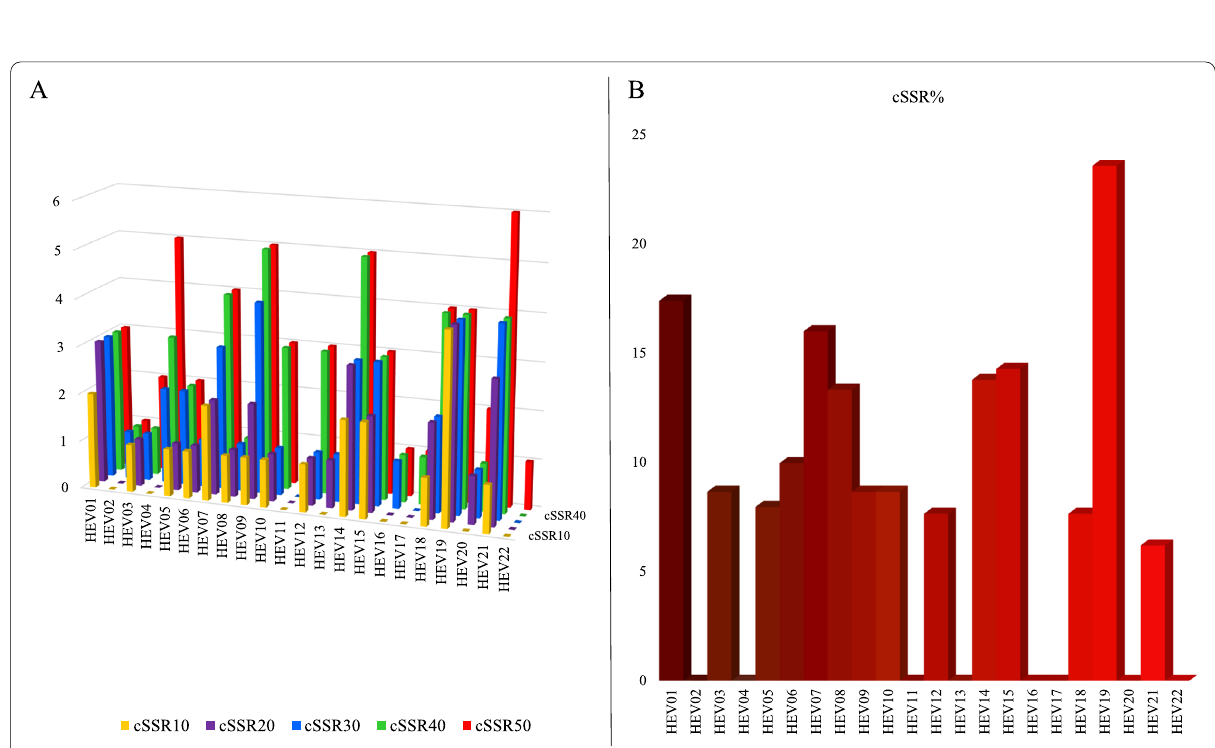
Fig. 5 Clustering of SSRs in Hepeviridae genomes. A cSSR%. B cSSR incidence with varying dMAX